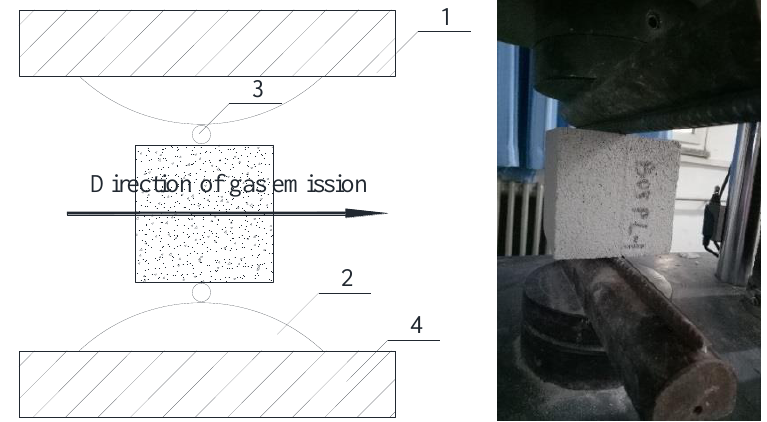
Figure 3. Test device of splitting tensile strength.